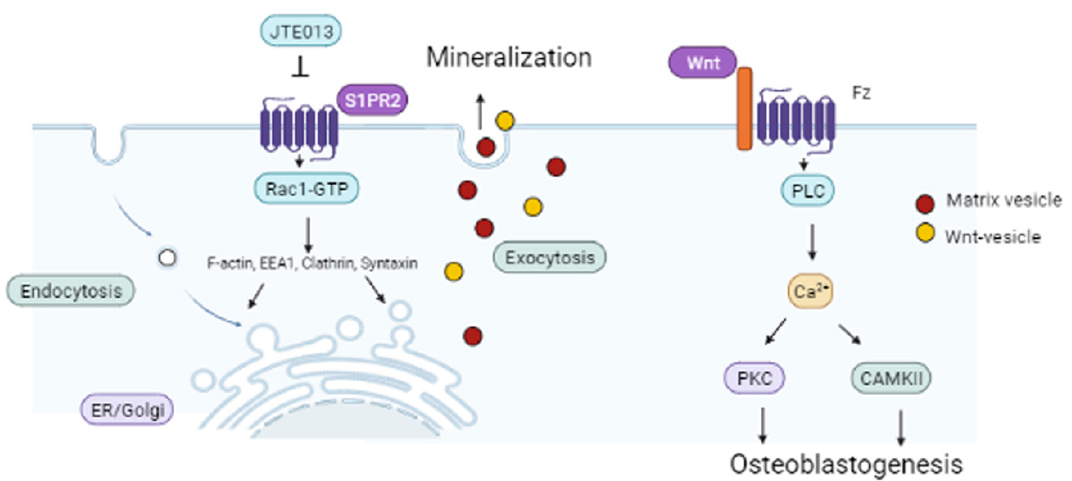
Figure 8. Schematic representation of the role of JTE013 in osteogenesis. Treatment with the S1PR2 antagonist, JTE013, increases Rac1-GTP, which promotes polymerization of actin to form F-actin and increases EEA1, clathrin, and syntaxin levels. These proteins, in turn, further stimulate both endocytosis and exocytosis. Exocytosis of Wnt vesicles excretes Wnt, which binds to the Fz receptor and activates PLC. Activation of PLC releases calcium, which serves as a second messenger to activate CaMKII and PKC. Activation of Wnt/Ca 2+ signaling promotes osteoblastogenesis. Additionally, the exocytosis of matrix vesicles promotes mineralization.